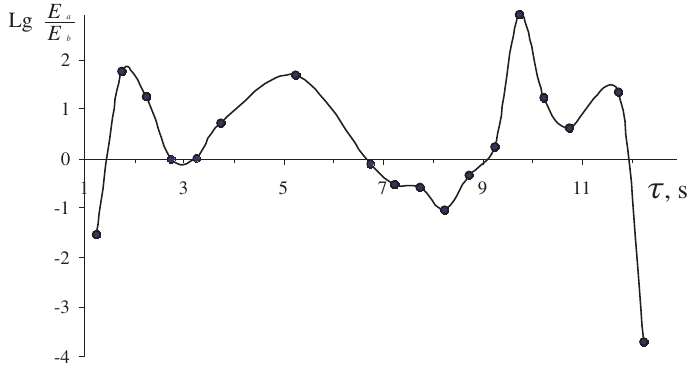
Fig. 11. Ratio E a / E b of total seismic energy of earthquakes of the North Tien Shan and adjacent areas occur- ring after and before MHD-generator start-ups as a function of the electromagnetic pulses duration. The values E a / E b are plotted on a logarithmic